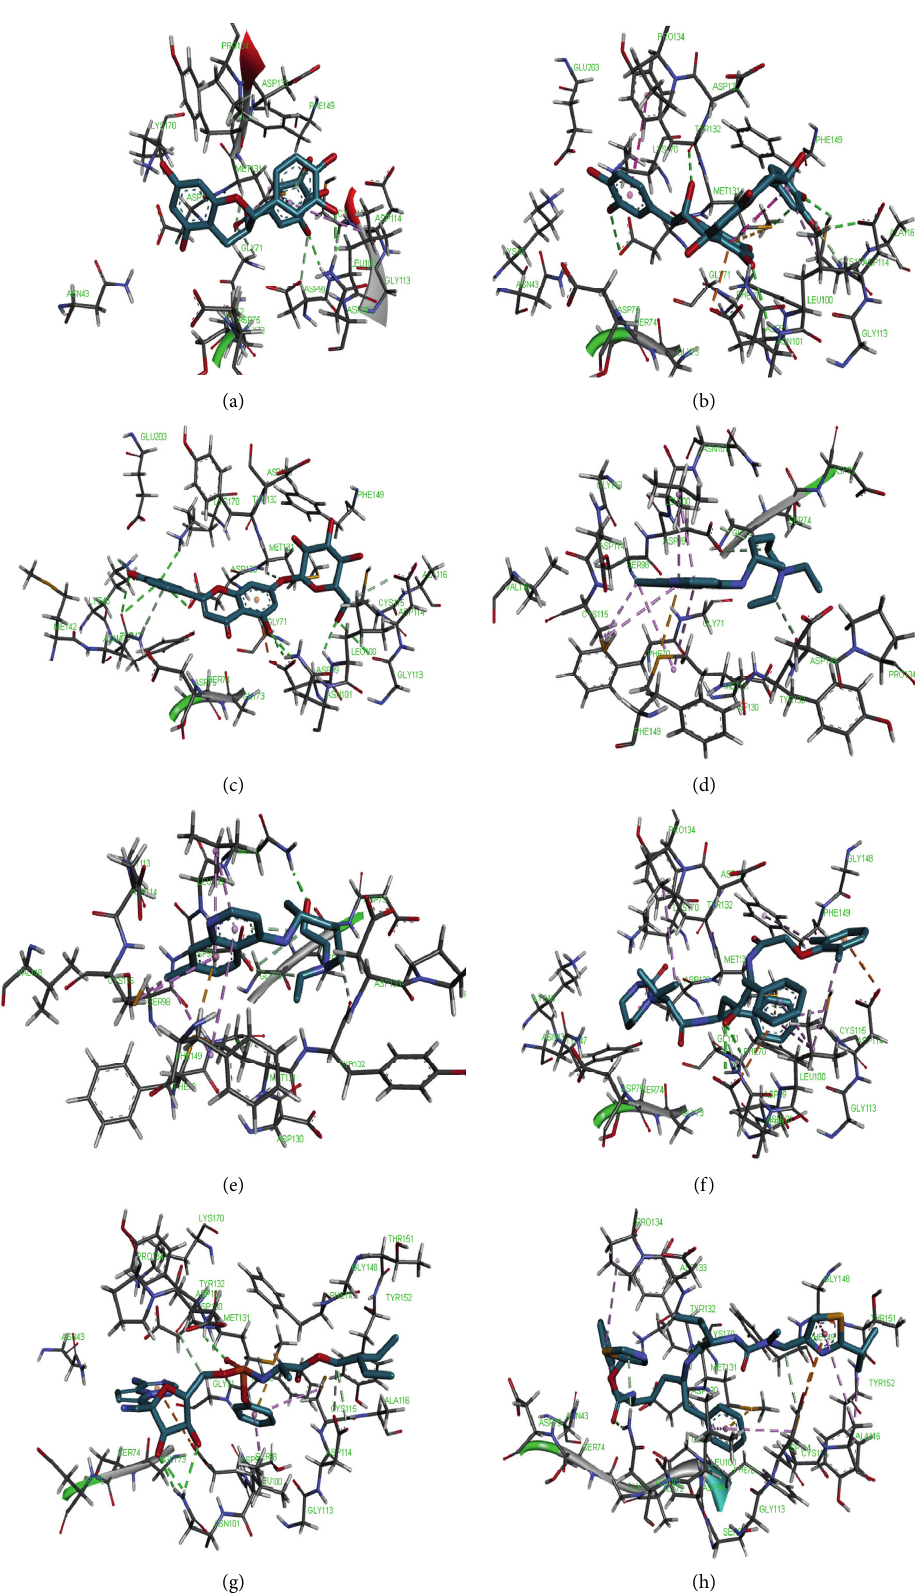
Figure 10: 3D representation of (a) 3-galloylcatechin, (b) proanthocyanidin B1, (c) luteolin 7-galactoside, (d) chloroquine, (e) hydroxychloroquine, (f) lopinavir, (g) remdesivir, and (h) ritonavir in the binding pocket of